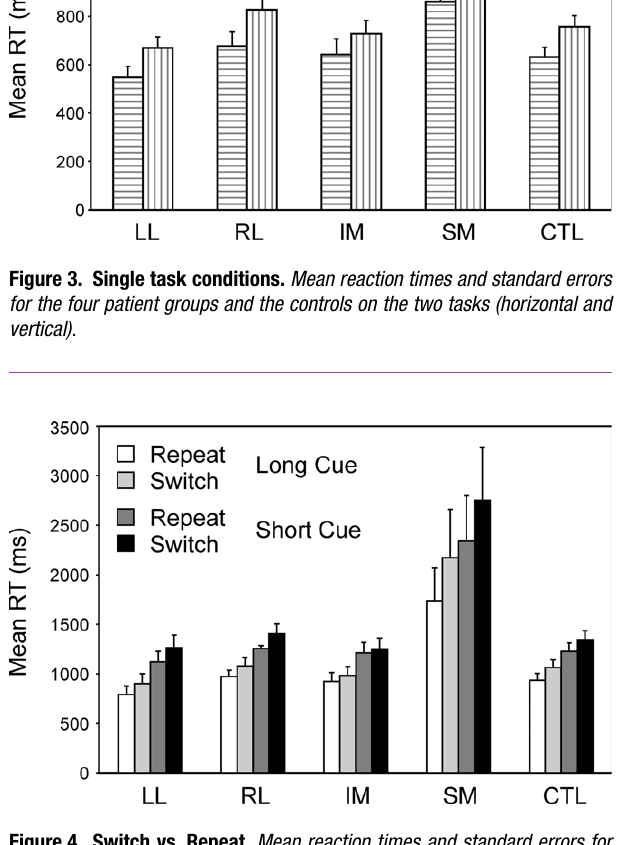
Figure 6. Horizontal vs. vertical. Mean reaction times and standard errors for the four patient groups and the controls on Horizontal and Vertical trials in the Long Cue and Short Cue task